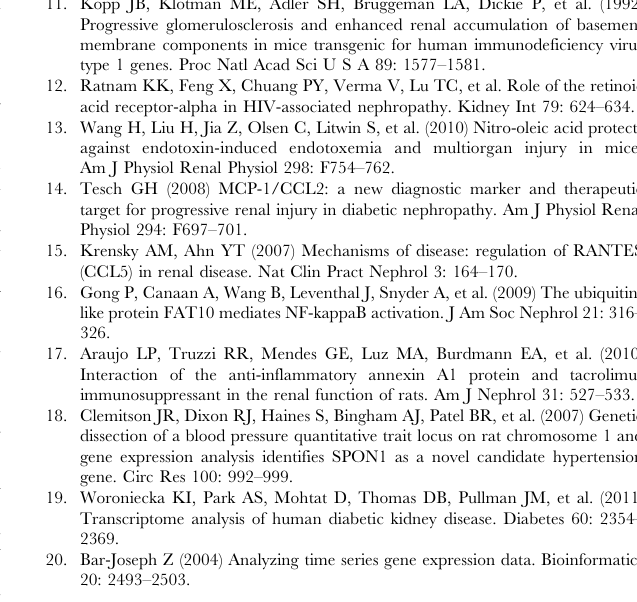
genes. Table S1 : The 69 genes, which were up-regulated at all three time points, were analyzed by using Enrichr KEGG program. Table S2 : The 69 genes, which were up-regulated at all three time points, were further analyzed by using Enrichr GO Biological Process program. Table S3 : The 1583 genes, which were up-regulated at late stage (12 weeks), were analyzed further by using Enrichr KEGG program. Table S4 : The 1583 genes, which were up-regulated at late stage (12 weeks), were analyzed further by using Enrichr GO Biological Process. Table S5 : The 313 genes, which were up-regulated transiently at the middle stage program. Table S6 : The 313 genes, which were up-regulated transiently at the middle stage (8 weeks), were analyzed further by using Enrichr GO Biological Process program. Table S7 : The 486 genes, which were down-regulated at the late stage (12 weeks), were analyzed further by using Enrichr KEGG program. Table S8 : The 486 genes, which were down-regulated at the late stage Process. Table S9 : The 54 genes, which were down-regulated transiently at 8 weeks of age, were analyzed further by using Enrichr KEGG program. Table S10 : The 54 genes, which were down-regulated transiently at 8 weeks of age, were analyzed further by using Enrichr GO Biological Process. Table S11 : 84 genes which were down-regulated between 4–8 weeks but no